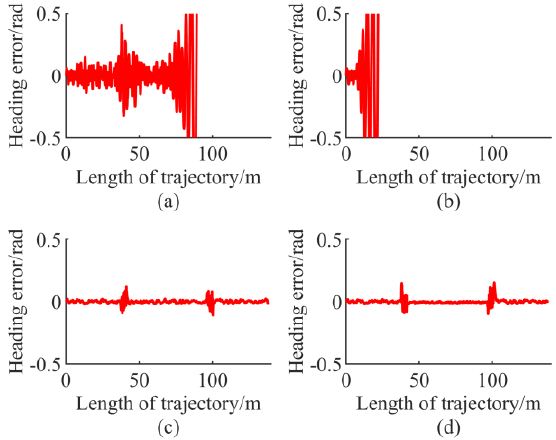
Figure 37. The heading error with the positioning error in ± 0.2 m. ( a ) LMPC. ( b ) LEMPC. ( c ) NMPC. ( d ) NEMPC.